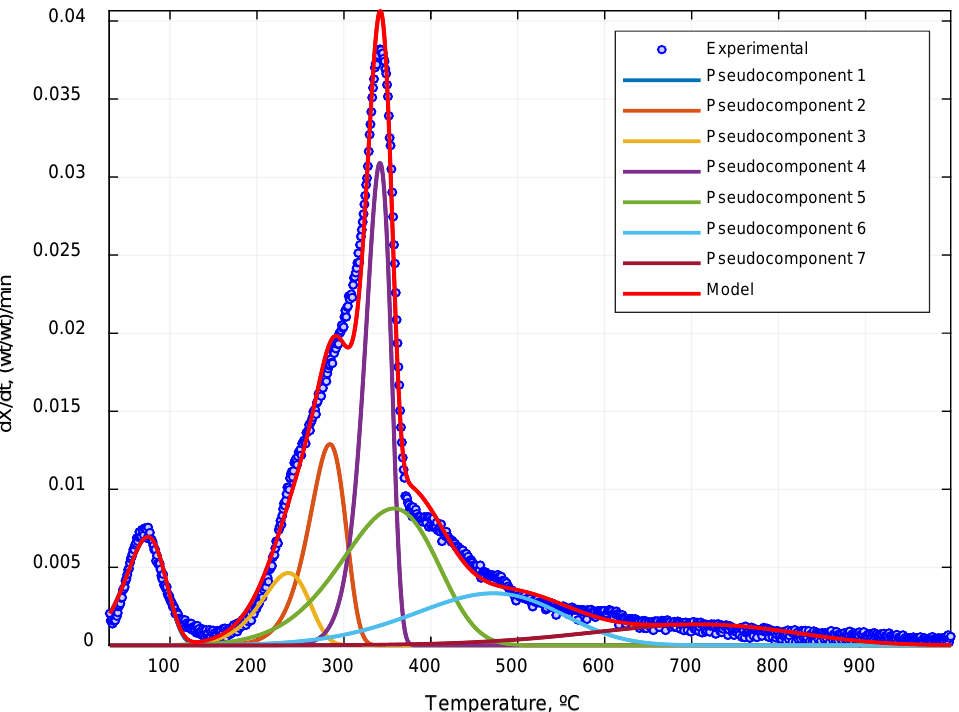
Figure 4. Model fitted to the experimental spruce bark DTG curve.